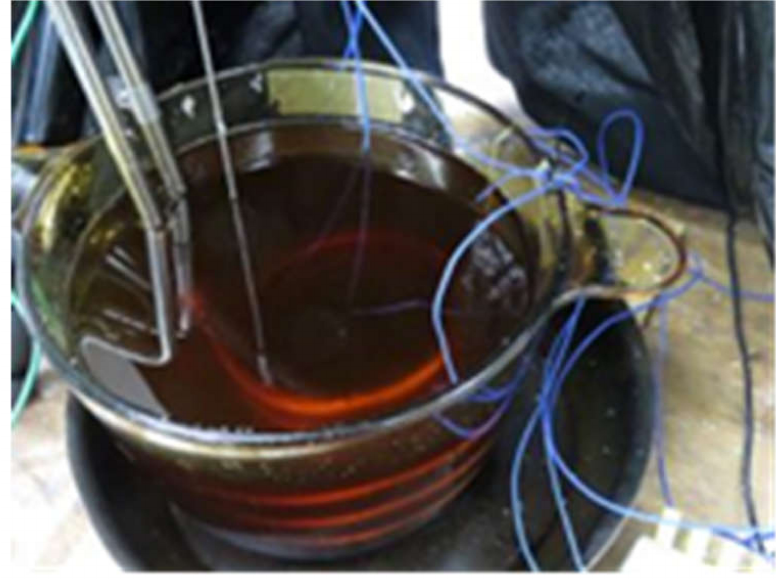
Figure 2. Experimental equipment for OCMT (Oshima College method), which is a technique for desalting and reducing the volume using heated vegetable oil (image provided by Kawahara).